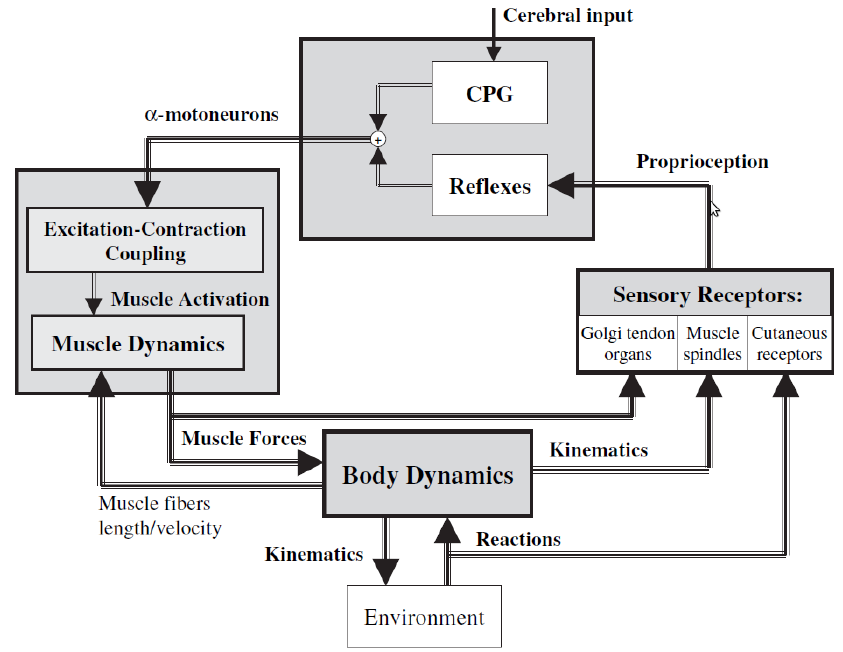
Figure 5. Global view of the human locomotion machinery (this figure is reproduced with permission from [63]; Copyright Springer-Verlag, 2005; see text for